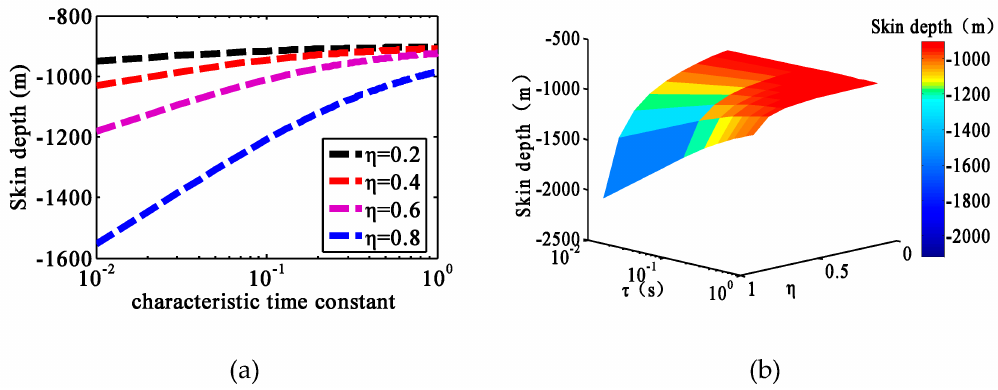
Figure 11. The e ff ect of the characteristic time constant and the chargeability on the skin depth (( a ) 2D curve, ( b ) 3D view).